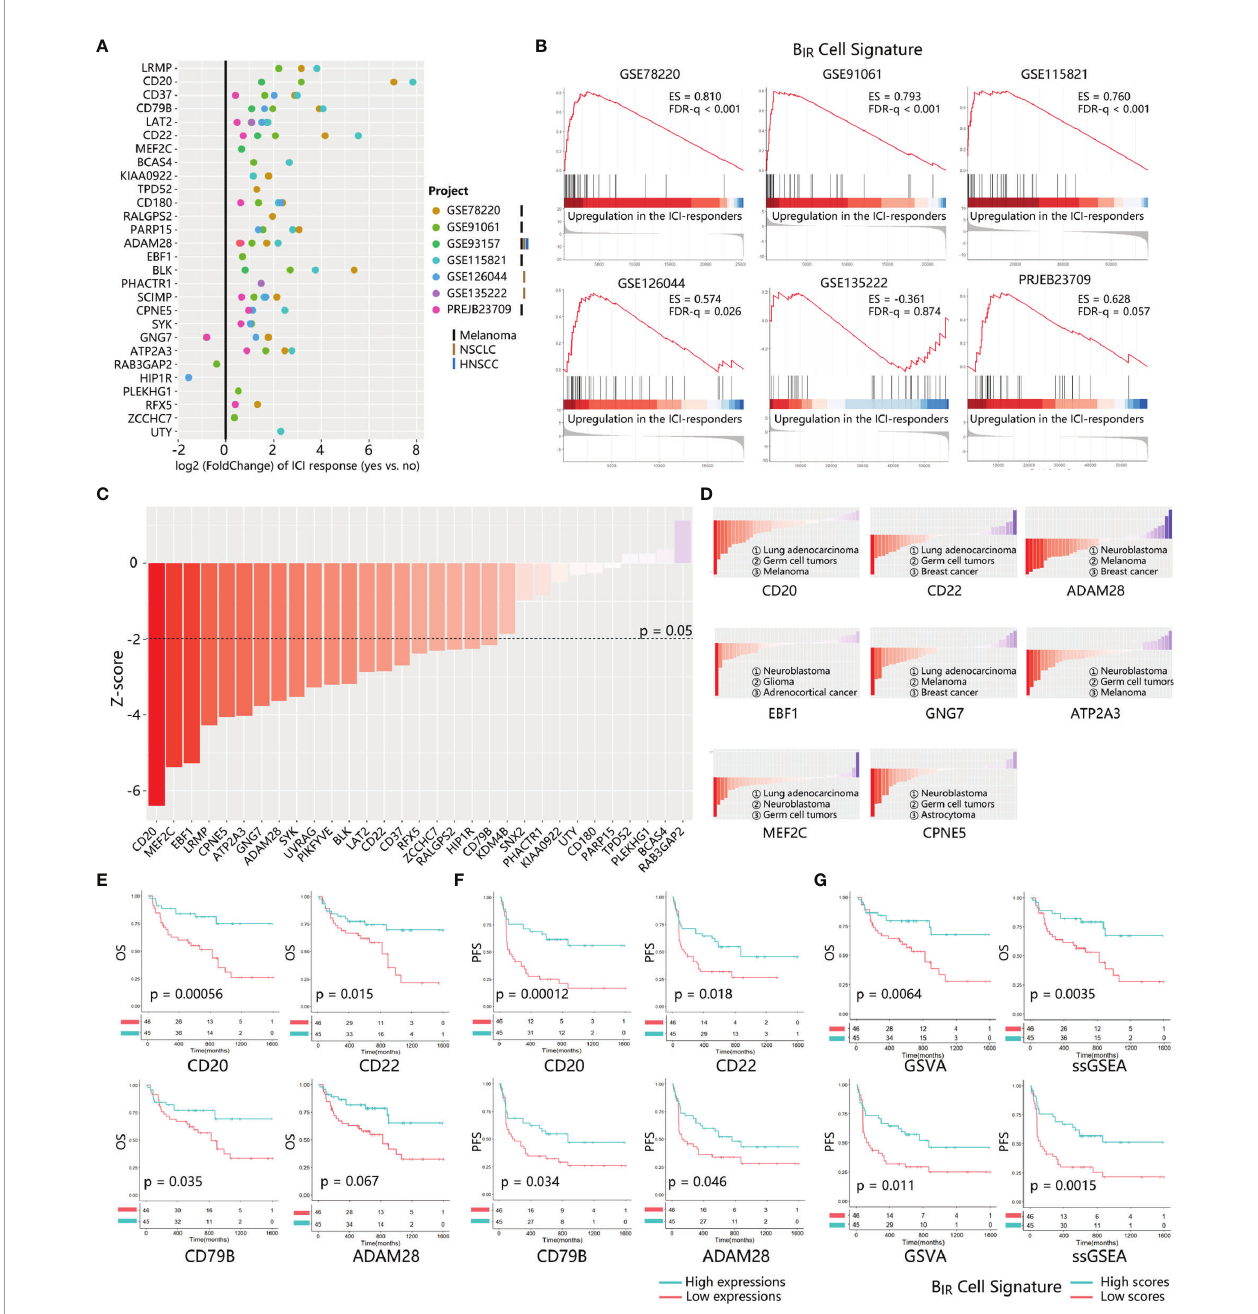
FIGURE 5 | Prognosis value of B IR cells signature in ICI-treated patients. (A) The fold change of gene expression in ICI responders as compared to non-responders is calculated for 28 genes from B IR cells. signature. 7 transcriptome datasets from ICI-treated patients with different tumor types (marked by different bars) are indicated by circle colors. Only signi fi cant fold changes (p < 0.05) are shown in the plot. (B) GSEA for gene expression pro fi les of B IR cells signature in multiple data sets. Hits (shown as black lines) are the transcripts of B IR cells signature showing upregulation in the ICI-responders compared with non-responders. Enrichment scores (ES) and false discovery rate (FOR) q value are shown beside enrichment plots. (C) Global PRECOG z-scores of 31 genes from B IR cells signature re fl ect their pan-cancer prognostic value. Genes are sorted according toz-score from favorable (red) to adverse prognostic genes (blue) in all kinds of cancers histology. The z- score threshold is set as ±1.96 (two-tailed P < 0.05) (D) PRECOG z-scores of each gene in different kinds of cancers histology.Histology with negative and positive z-scores individually indicates favorable (red) or adverse (blue) prognostic value of the gene in this tumor type. Solid tumor types with the top 3 minimum z-scores are shown for each gene. Correlations of critical genes of B IR cells signatures with overall survival (OS) (E) and progression-free survival (PFS) (F) in PRJEB23709.The red line designates the samples with lowly expressed genes, and the blue line indicates the samples with highly expressed genes. (G) OS (up) and PFS (down) analysis of B IR cells signature scores in PRJEB23709. Gene signature scores are quanti fi ed by GSVA (left) or ssGSEA (right) method. The red line designates the samples with lowly B IR cells signature scores, and the blue l ine indicates the samples with highly B IR cells signature